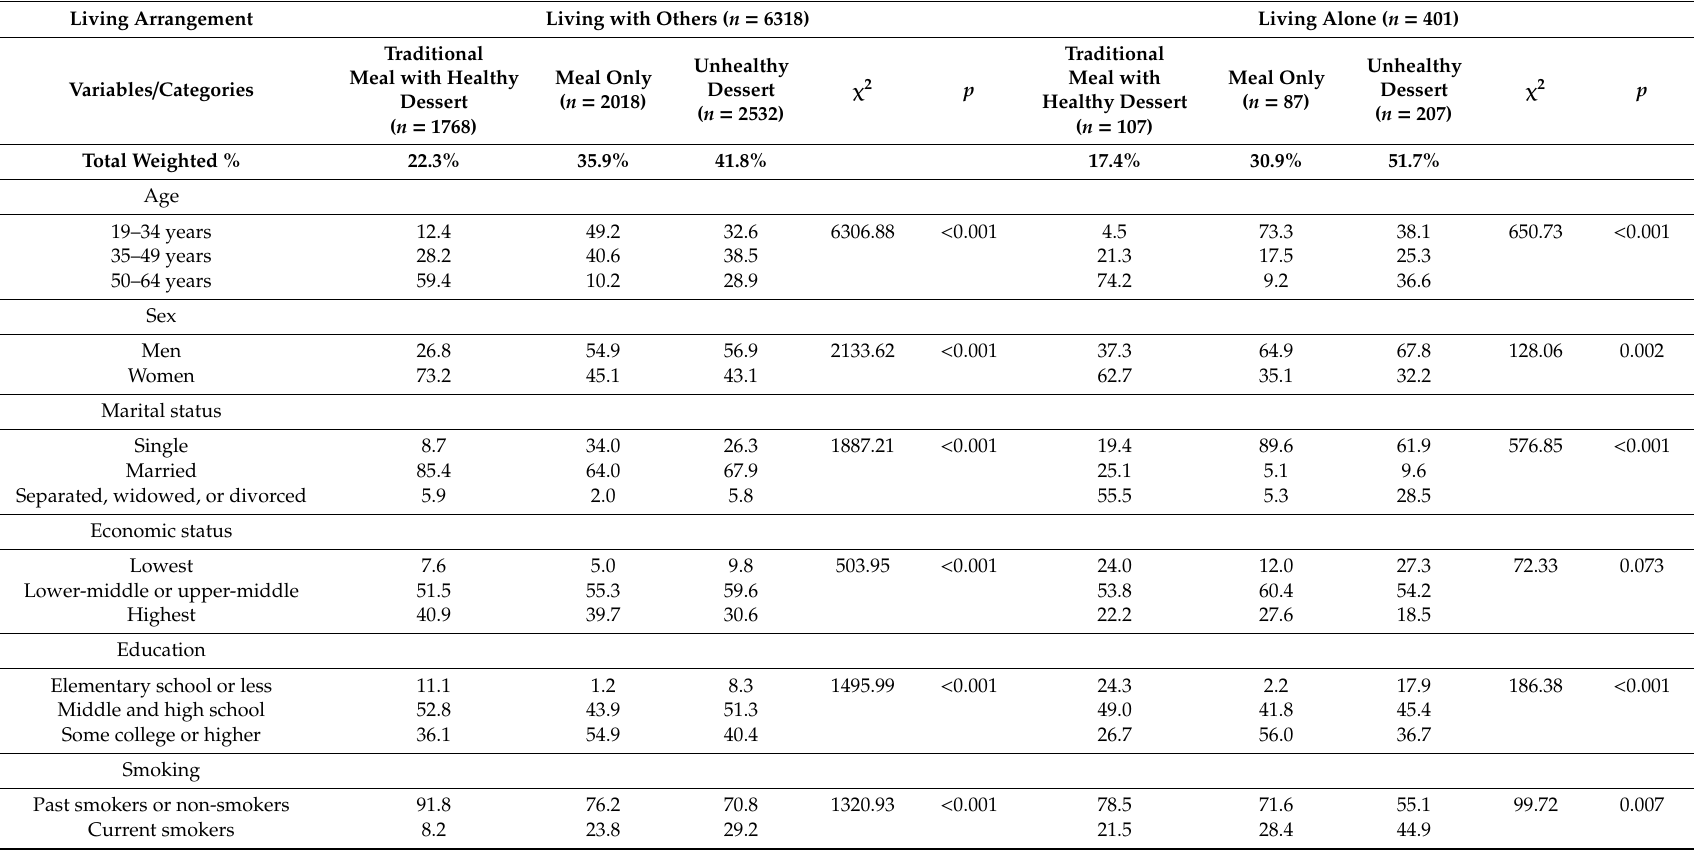
Table 4. Dietary patterns and characteristics of participants by living arrangement ( n =